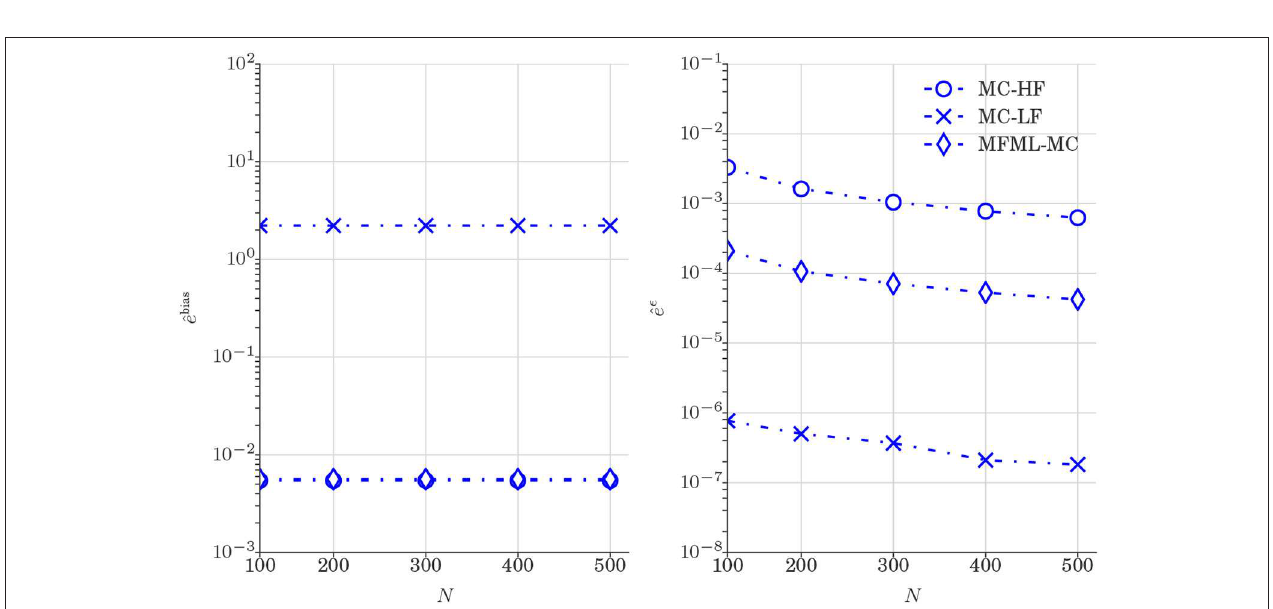
FIGURE 9 | Test case 2: Plot of e bias t and e ǫ t are shown as a function of computational budget p ˆ ˆ e bias t (Left) ˆ